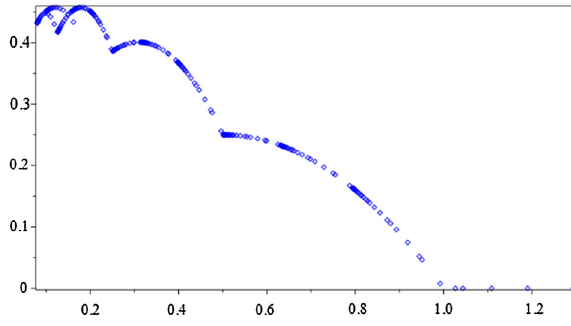
Fig. 3 h ( t ) as a function of ˜ T with l ( t ) = t ( 1 − t ) for t ∈ [ 0 , 1 ] , otherwise l ( t ) = 0, and α = 1